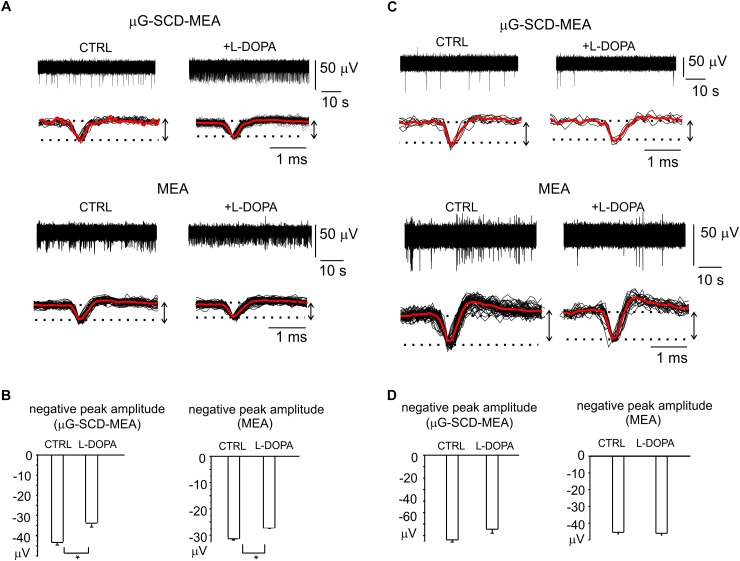
Heterogeneity of L-DOPA-induced responses on midbrain neurons viewed through μG-SCD-MEAs and MEAs. (A) Representative recordings of L-DOPA-induced potentiation of neuronal firing, respectively acquired by μG-SCD-MEAs (top) and MEAs (bottom). Under each recording, individual (black) and averaged signals (red) are shown on an expanded time scale. (B)
L-DOPA induced potentiation is associated to the reduced amplitude of the AP peak, as shown in the bar histograms. (C)
L-DOPA reduces the firing frequency without causing any significant alteration in the extracellularly recorded peak amplitude. Significant recordings detected by μG-SCD-MEAs (top) and MEAs (bottom). (D) The bar histograms show the mean negative peak amplitude, which is not affected by L-DOPA, for both devices.